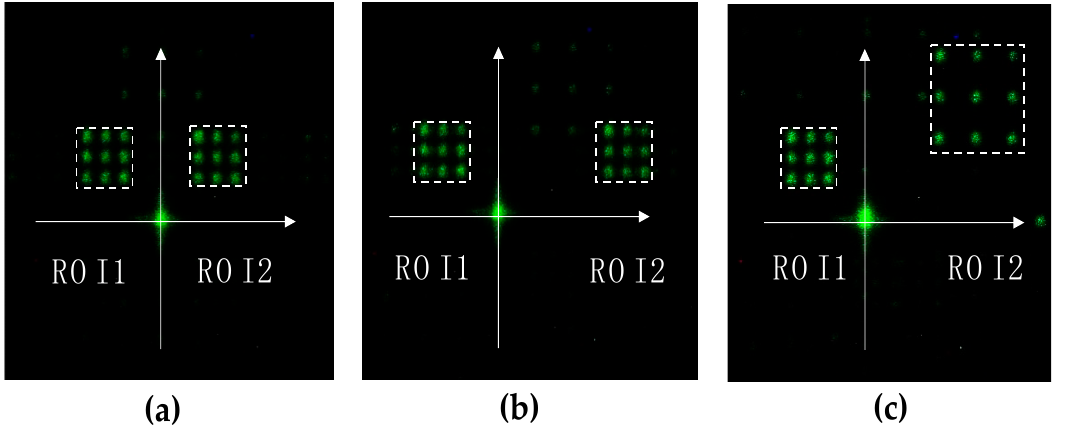
Figure 9. Long exposure of simultaneous scanning of two ROIs. With respect to the y -axis, ROIs are defined as ( a ) symmetrical with equal area, ( b ) asymmetrical with equal area, and ( c ) asymmetrical with non-equal area.